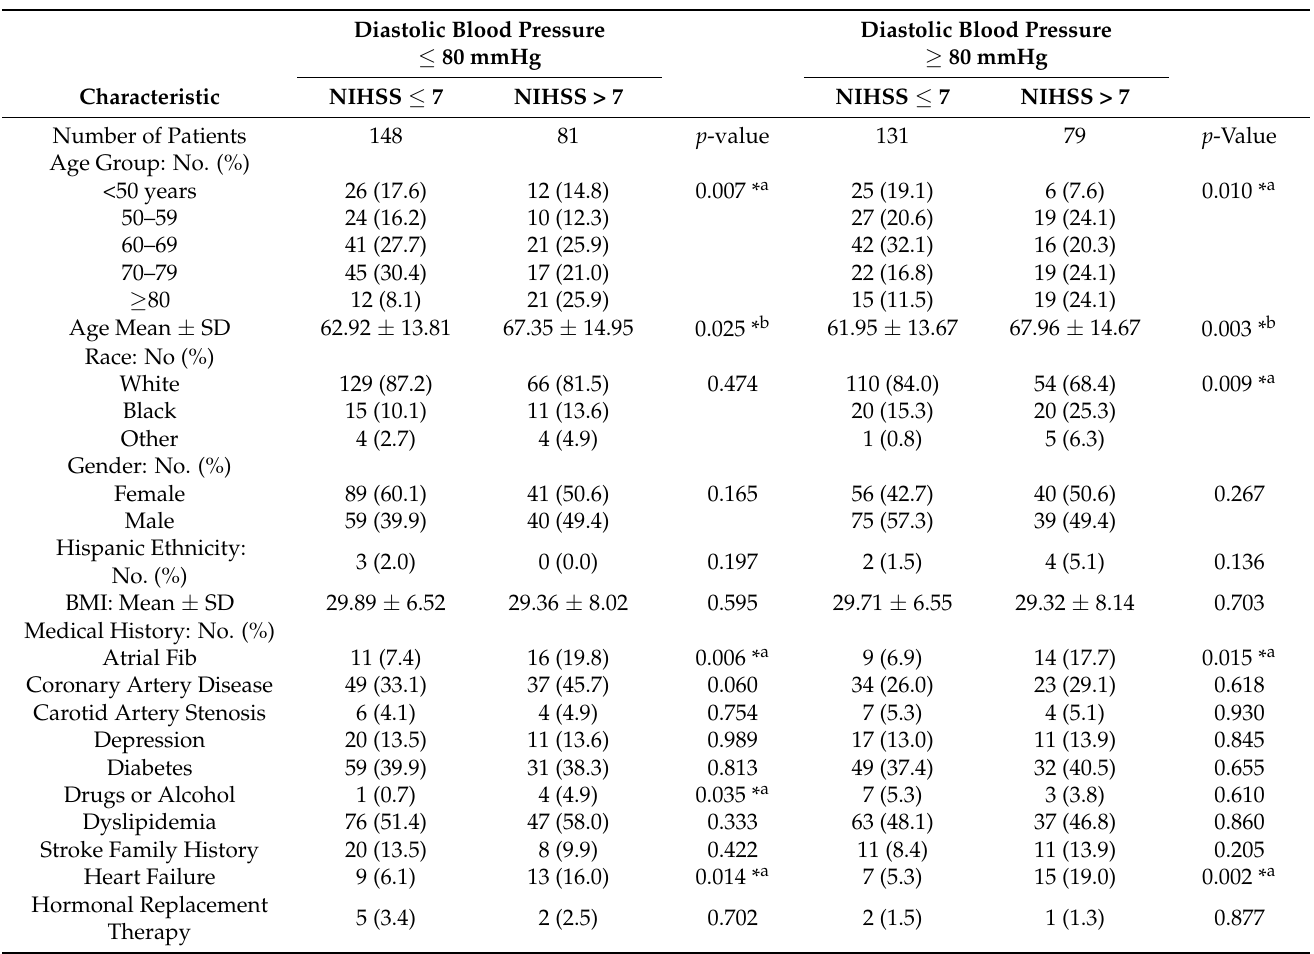
Table 2 presents the demographic and clinical risk factors in AIS patients stratified by NIHSS scores ( ≤ 7 or >7) for AIS with DBP ≤ 80 mm Hg and >80 mmHg. Patients with a DBP ≤ 80 mmHg and NIHSS > 7 were more likely to be older (67.35 ± 14.95 vs. 62.92 ± 13.81) with higher rates of atrial fibrillation (19.8% vs. 7.4%), coronary artery disease (45.7% vs. 33.1%), history of drug or alcohol abuse (4.9% vs. 0.7%), dyslipidemia (58.0% vs. 51.4%), heart failure (16.0% vs. 6.1%), and hypertension (84.0% vs. 70.9%), but with lower rates of obesity (38.3% vs. 53.4%). This group significantly differed regarding ambulation status before admission, during admission, and at discharge. AIS patients with a DBP > 80 mmHg and NIHSS > 7 were more likely to be older (67.96 ± 14.67 vs. 61.95 ± 13.67) and less likely to be Caucasians (68.4% vs. 84.0%). In addition, they presented with higher rates of atrial fibrillation (17.7% vs. 6.9%), coronary artery disease (29.1% vs. 26.0%), heart failure (19.0% vs. 5.3%), hypertension (88.6% vs. 74.0%) and peripheral vascular disease (12.7% vs. 4.6%). They presented with higher INR (1.1 ± 0.27 vs. 1.01 ± 0.12), were less likely to be directly admitted for treatment (60.3% vs. 79.4%), and were more likely to show improvement in ambulation (60.9% vs. 41.2%). Table 2. Demographic and clinical characteristics of an NIHSS score > 7 in ischemic stroke patients in the telestroke network stratified by diastolic blood pressure ≤ 80 mmHg or >80 mmHg. Results for continuous variables are presented as mean ± SD, while discrete data are presented as percentage frequency. Pearson’s Chi-squared is used to compare differences between demographic and clinical characteristics in groups with an NIHSS score greater than 7 in the telestroke based on diastolic blood pressure ≤ 80 mmHg or >80 mmHg. Diastolic Blood Pressure Diastolic Blood Pressure ≤ 80 mmHg ≥ 80 mmHg